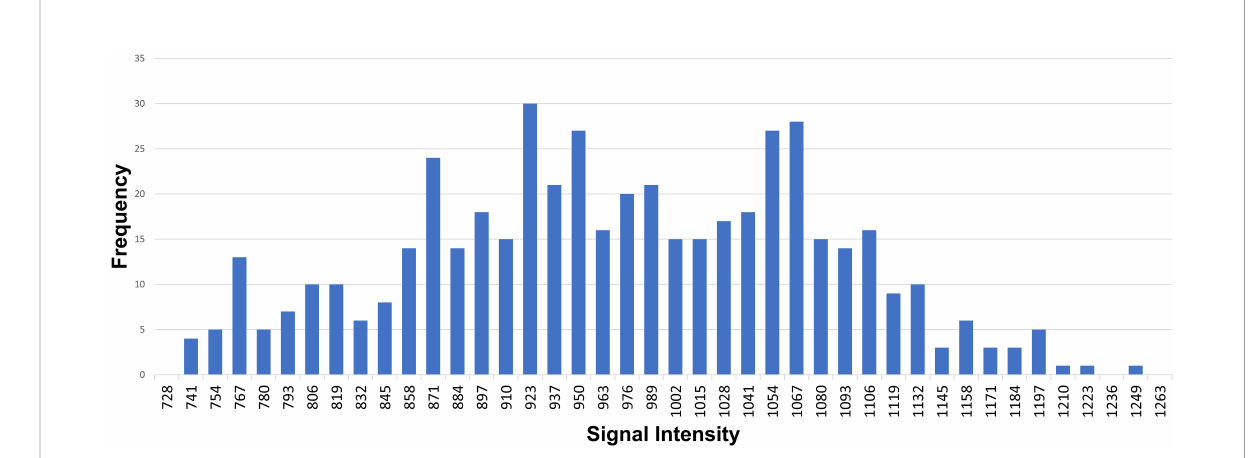
FIGURE 3 An example of whole-tumor histogram analysis of the ADC map. A 35-year-old female patient with primary mediastinal large B-cell